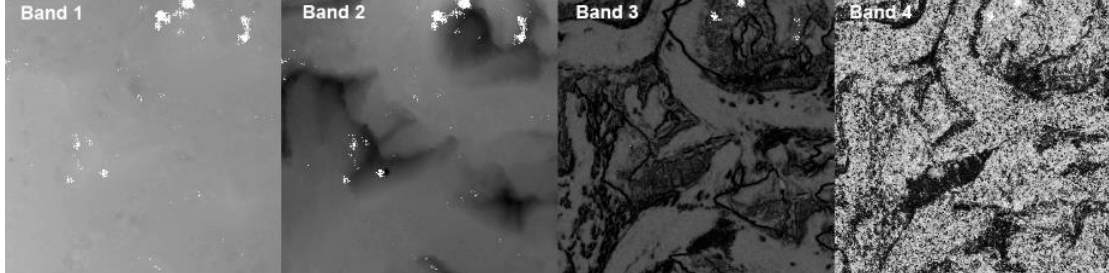
Figure 5. Small disparity map extract. Band 1: disparities in column direction; Band 2: disparities in line direction; Band 3: feature distances; Band 4: backmatching distances.